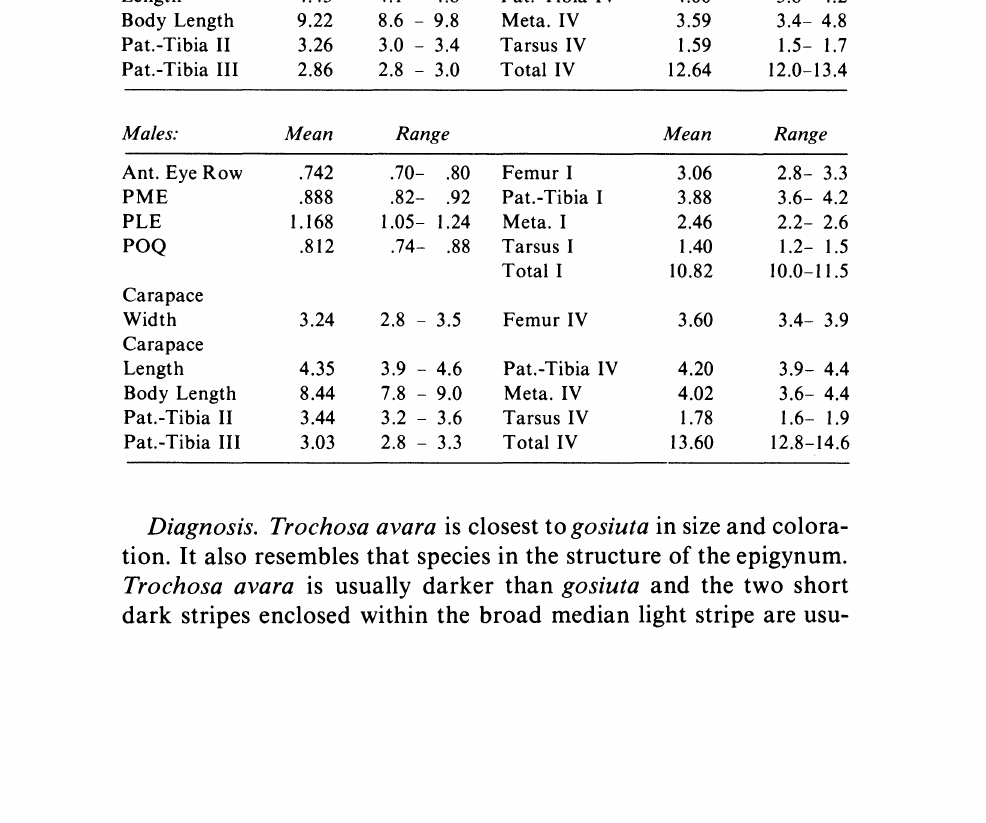
Dorsum of abdomen with yellow ground color, suffused with brown and spotted with black. Cardiac area solid brown. Legs pale yellow to light brown, darker above. Labium and endites yellow with distal ends cream. Sternum yellow. Measurements. Ten females and ten males from Ramsey, Bergen Co., New Jersey.